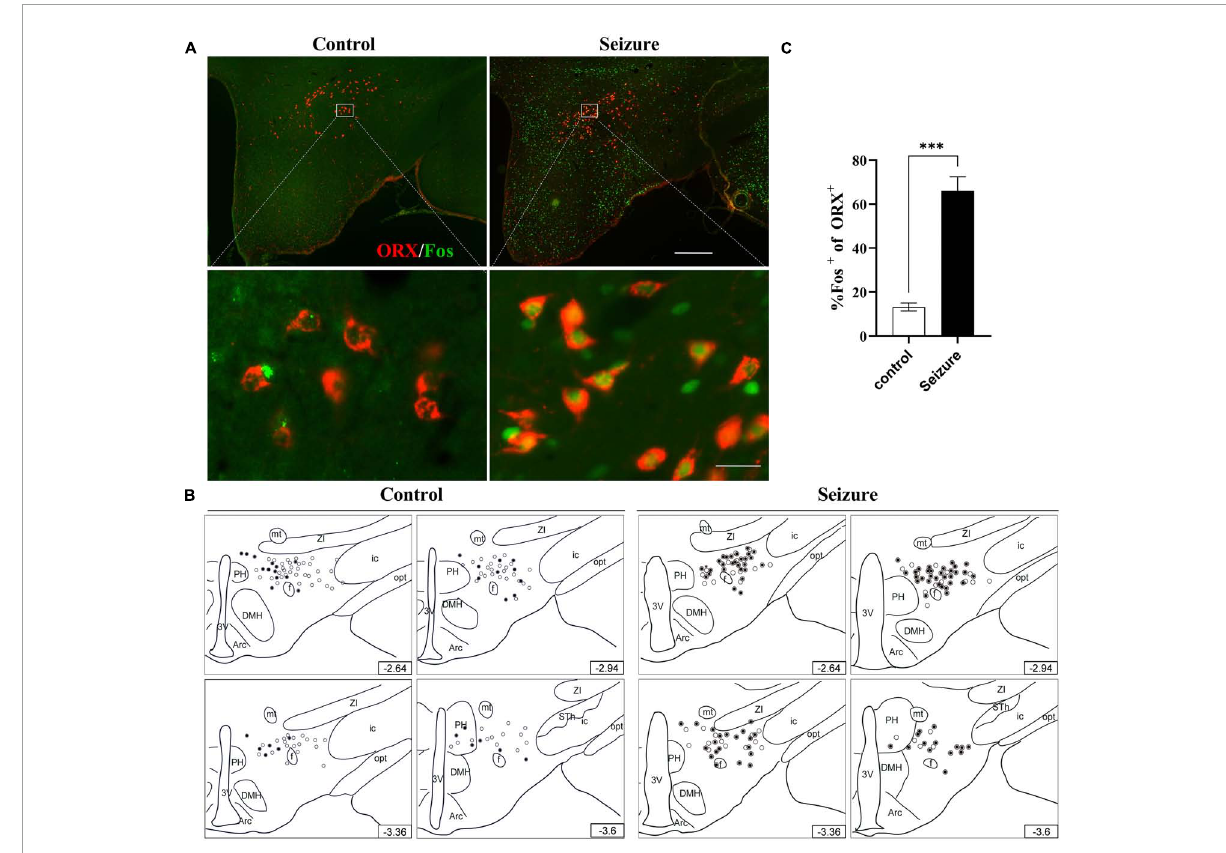
FIGURE3 Hypothalamic ORX neurons were activated in seizure rats. (A) Representative images of double immunofluorescent staining for ORX (red) and Fos (green) in the hypothalamus of a control and a seizure rat; bar: 500 µ m in the upper panel and 30 µ m in the lower panel. (B) The distribution of Fos + (filled circle) or Fos − ORX neurons (clear circle) in 4 rostral-caudal sections of hypothalamus of control and seizure rats, with each clear circle representing 3 Fos − ORX neurons and each filled circle representing 3 Fos + ORX neurons. The number on the lower right of each section indicates the distance from the bregma; (C) bar graph showing the proportion of ORX neurons that were activated (Fos + ). ∗∗∗ P < 0.001, n = 4 rats for each group, Student’s t -test. 3V, third ventricle; Arc, arcuate hypothalamic nucleus; DMH, dorsomedial hypothalamic nucleus; f, fornix; ic, internal capsule; mt, mammillothalamic tract; opt, optic tract; PH, posterior hypothalamic nucleus; STh, subthalamic nucleus; ZI, zona